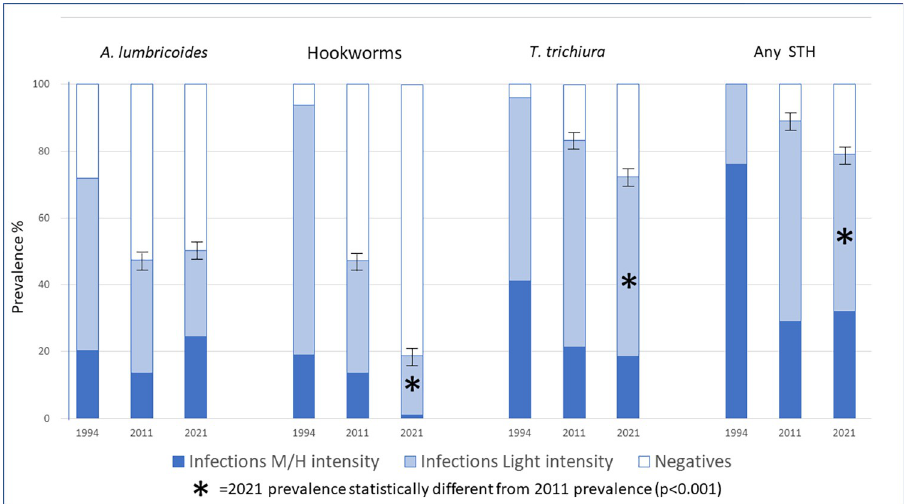
Fig 2. Categories of intensity of infection for each of the three STH parasites and for any infection from 1994 to 2021.